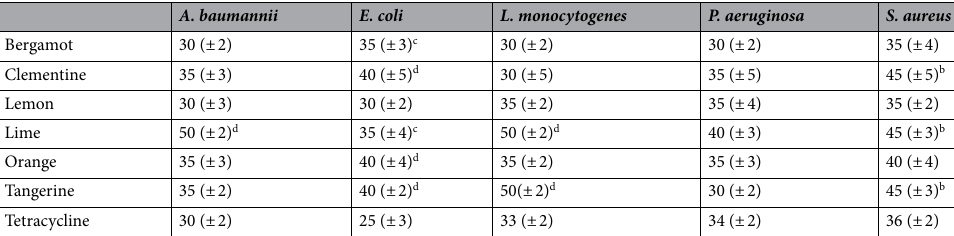
Table 2. Minimal inhibitory concentration (MIC, µ g/mL) of the monofloral Citrus honeys, needed to block the metabolic activity of the five bacterial strains, evaluated through the resazurin test. Results are expressed as the mean of three experiments ± SD. a: p < 0.5; b: p < 0.01; c: p < 0.001; d: p < 0.0001 compared with the tetracycline used as control (ANOVA followed by Dunnett’s multiple comparison test).